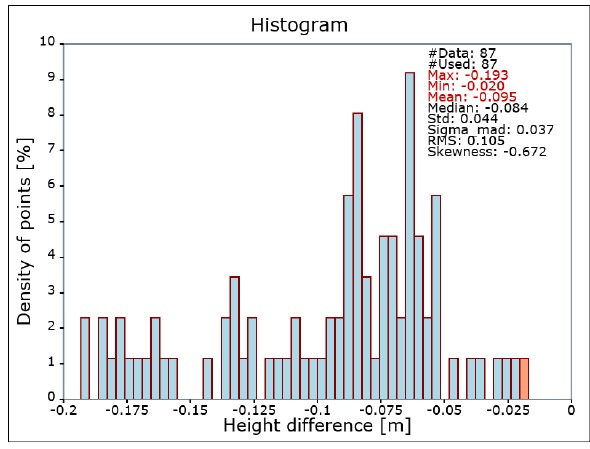
Figure 7. Height difference between control points and DTM robust moving